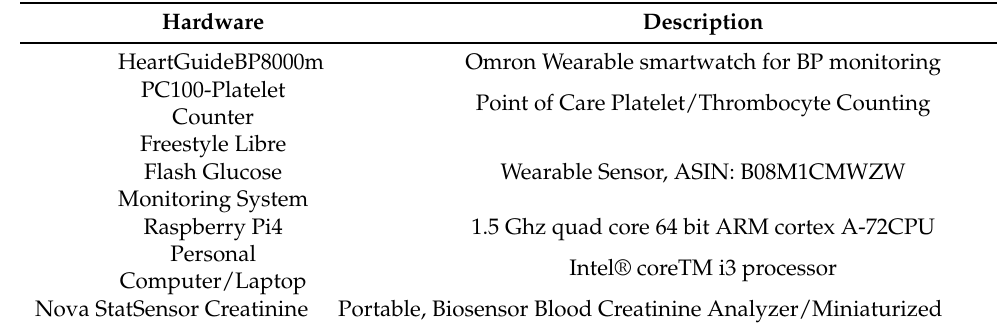
Table 5. Proposed Hardware for CDF-DI System.